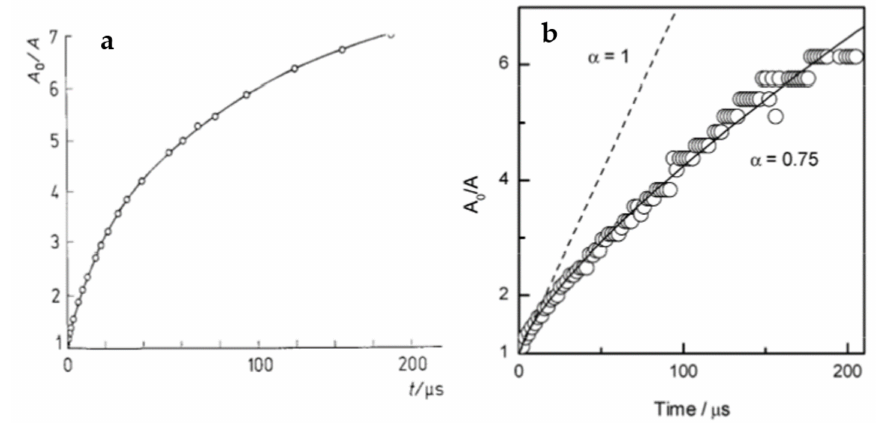
Figure 5. Exemplary second-order kinetic plots for intramolecular polymer radical recombination obtained by pulse radiolysis in deoxygenated, dilute aqueous solutions. ( a ) Poly(vinyl alcohol), M n ca. 55 kDa, polymer chain concentration 0.8 µ M, initial radical concentration 22 µ M, Z R 0 = 28. Adapted with permission from [62]; published by John Wiley and Sons, 2003. ( b ) Poly(acrylic acid) at pH 2, M n ca. 260 kDa, polymer chain concentration 4.8 µ M, initial radical concentration ca. 99 µ M, Z R 0 = 21. Adapted with permission from [59]; published by American Chemical Society, 2003. Dots denote experimental data; the broken line is the expected classical second-order behavior; the solid line is fitted using Equation